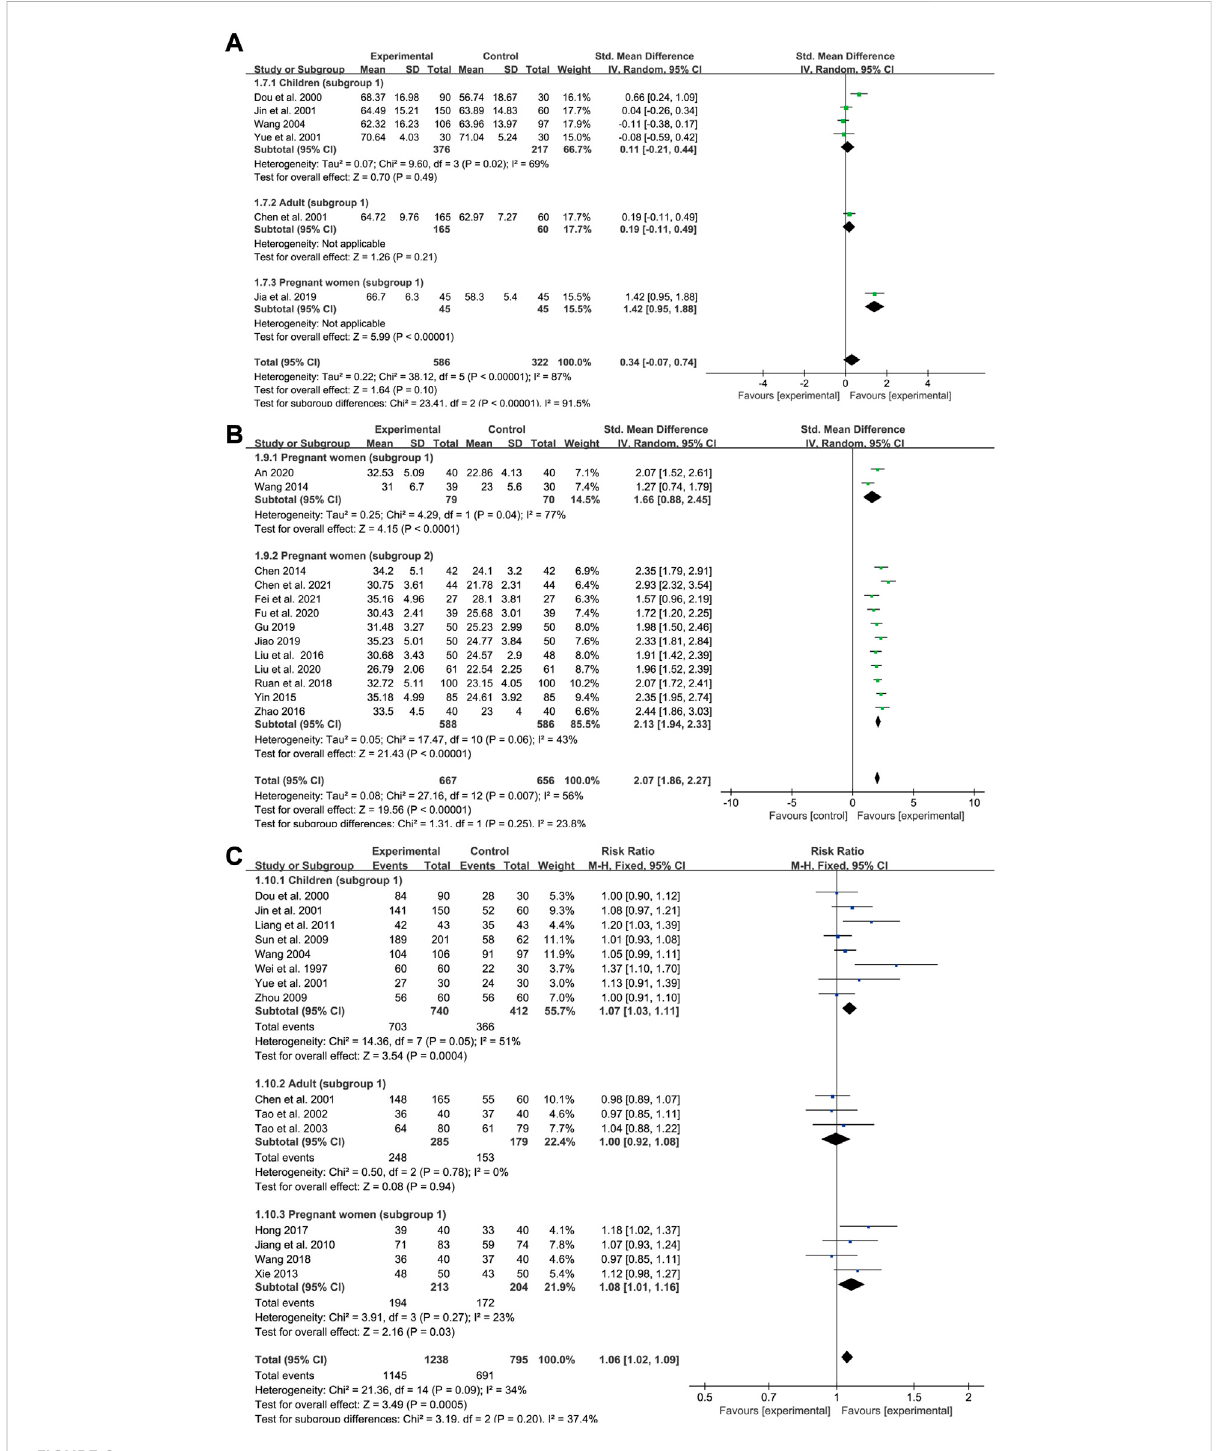
FIGURE 8 The forest plot assessing the effect of SXN on TIBC (A) , TSAT (B) , and total effective rate (C)